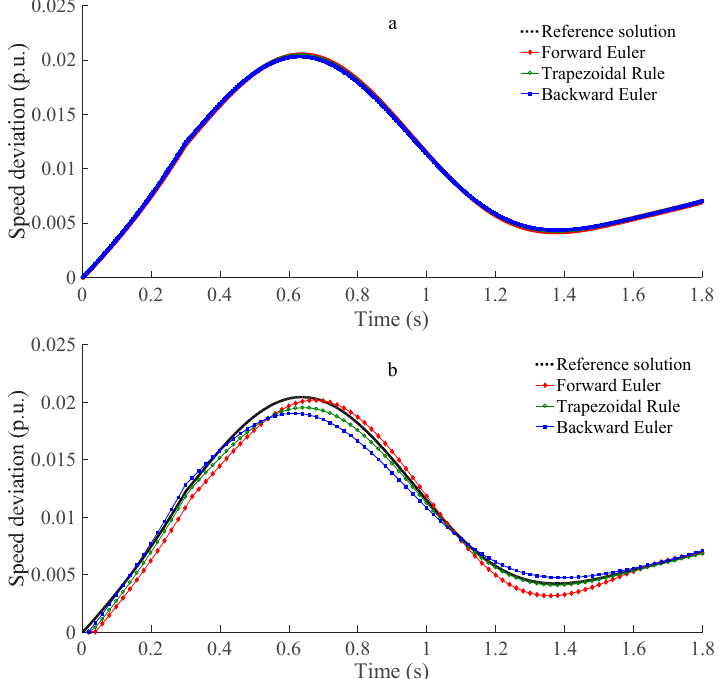
Figure 5. Rotor speed deviation at the generator at bus 33 when a short circuit is applied at bus 16. ( a ) with an integration time step of 0.002 s ( b ) with an integration time step of 0.02.